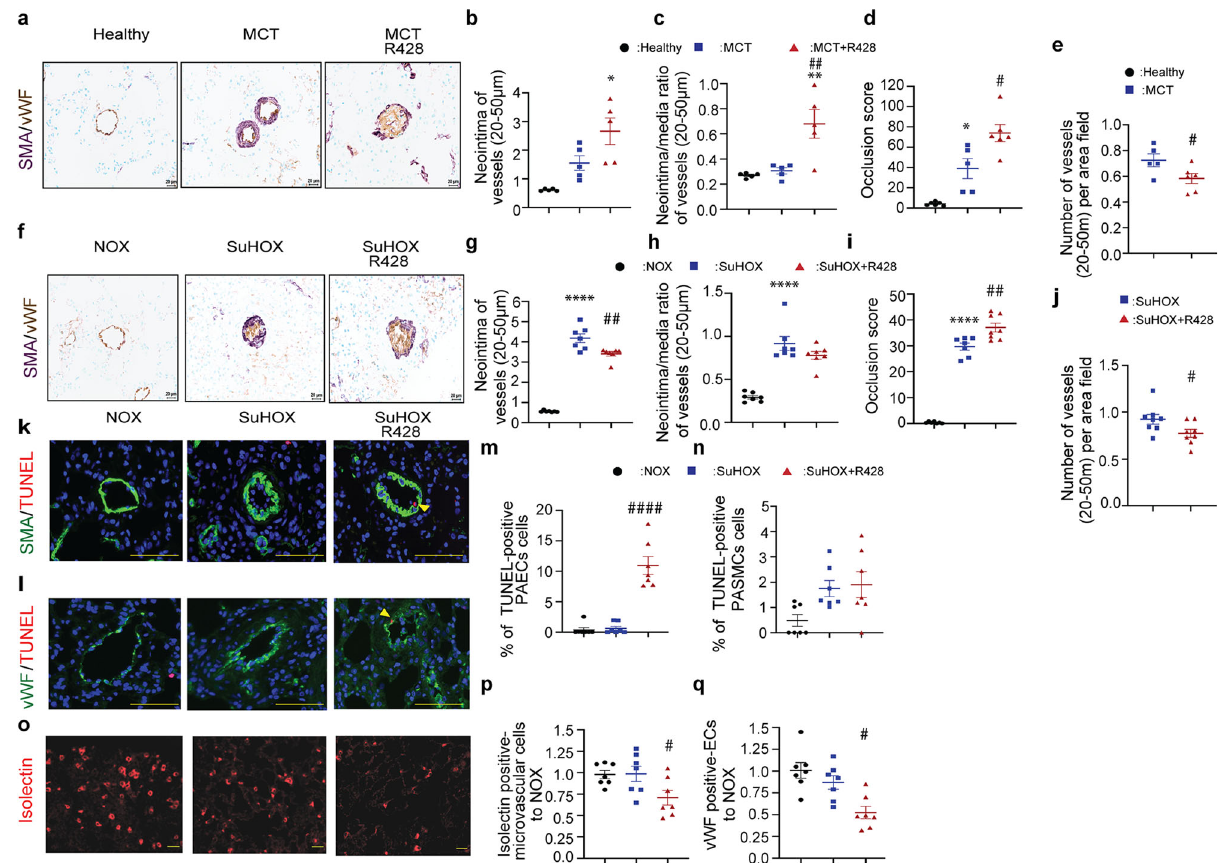
Fig. 6 Axl blockage by R428 administration exacerbates lung tissue remodeling in monocrotaline (MCT) and Sugen 5416/hypoxia (SuHOX) experimental rat models of pulmonary hypertension. a , f Representative images of immunohistological staining of lung sections for von Willebrand factor (vWF; brown) and α -smooth muscle actin ( α -SMA; violet) in a monocrotaline (MCT) and f Sugen 5416/hypoxia (SuHOX) models of pulmonary hypertension. Scale bar: 20 µ m. b , g The neointima thickness ( µ m) and c , h the neointima/media of the studied groups determined by Elastica-van-Gieson staining in the vessels with a diameter of 20 – 50 µ m. d , i Number of occluded vessels with a diameter of 20 – 50 µ m (per 100 vessels). e , j Number of vessels counted per lung (normalized per surface area) a – i MCT model: healthy, n = 5 – 6; MCT + placebo [MCT], n = 5; MCT + R428, n = 6. SuHOX model: NOX, n = 7; SuHOX + placebo [SuHOX], n = 7 – 8; SuHOX + R428, n = 7 – 8 biological independent animals. Data are presented as mean ± SEM of all counted vessels per lung. k , l Representative images and m , n quanti fi cation of TUNEL-positive cells in lungs of SuHOX rats and controls ( k α -SMA [green] and l vWF [green]; nuclei, blue (diamidino-2-phenylindole [DAPI]). Graphs represent the percentage of PASMCs and PAECs positive for TUNEL in distal pulmonary vessels of lung rats. o Representative images and p quantitative analysis of immuno fl uorescent staining of lung sections for pulmonary microvascular endothelial cells (PMVECs) using isolectin IB4 (red). Scale bar = 50 µ m. q Quantitative analysis of immuno fl uorescent staining of lung sections for pulmonary endothelial cells (PAECs) using vWF antibody. m – q NOX, n = 7; SuHOX + placebo [SuHOX], n = 7; SuHOX + R428, n = 7 biological independent animals. b – d * P < 0.05, ** P < 0.01 for MCT (or MCT + R428) versus healthy; g – i **** P < 0.0001 for SuHOX (or SuHOX + R428) versus NOX; c – j # P < 0.05, ## P < 0.001, and #### P < 0.001 for MCT + R428 and SuHOX + R428 versus MCT or SuHOX, respectively. Black circles NOX controls; blue squares SUHOX; red triangles SuHOX + R428. b – q Statistical analyses were performed using one-way ANOVA with Tukey ’ s post hoc test for multiple comparisons. e , j Student ’ s t -test was applied. All the data represent the mean ±